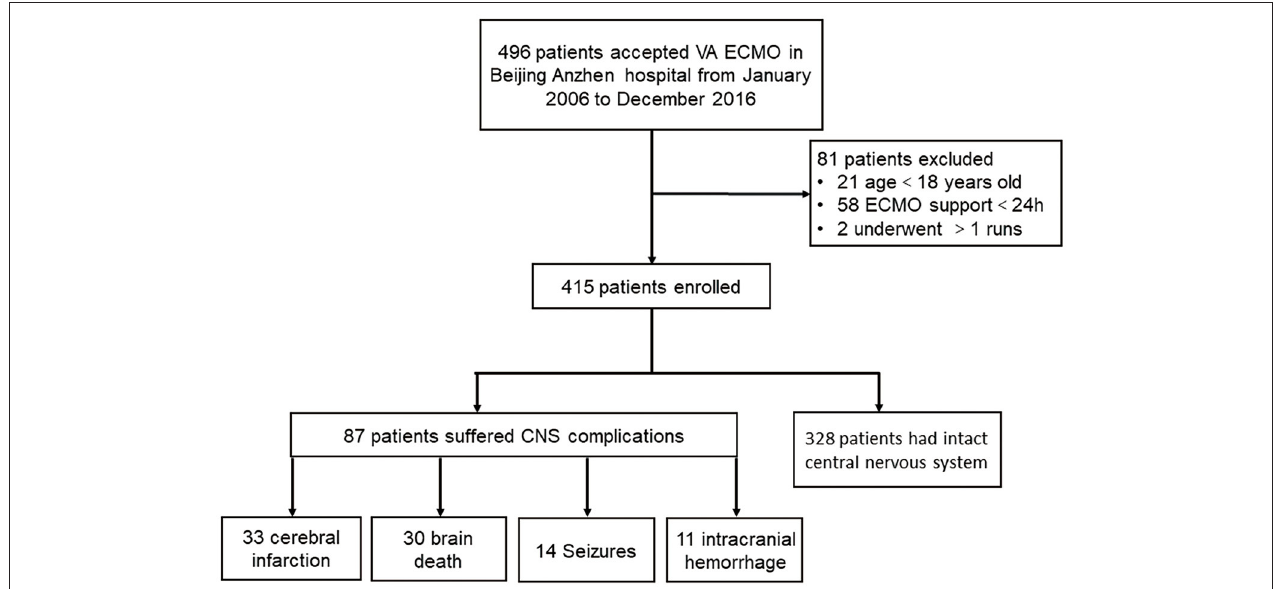
FIGURE 1 | Study flow. CNS, central nervous